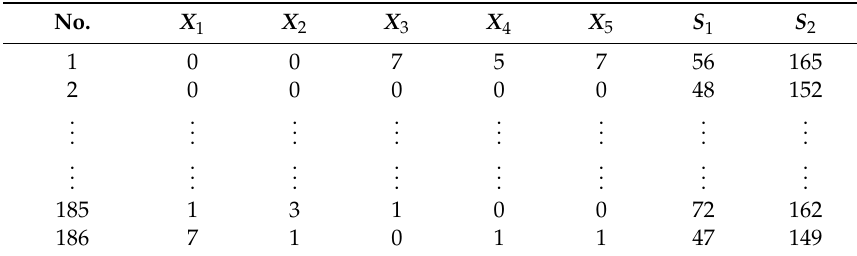
Table 4. Original survey data.